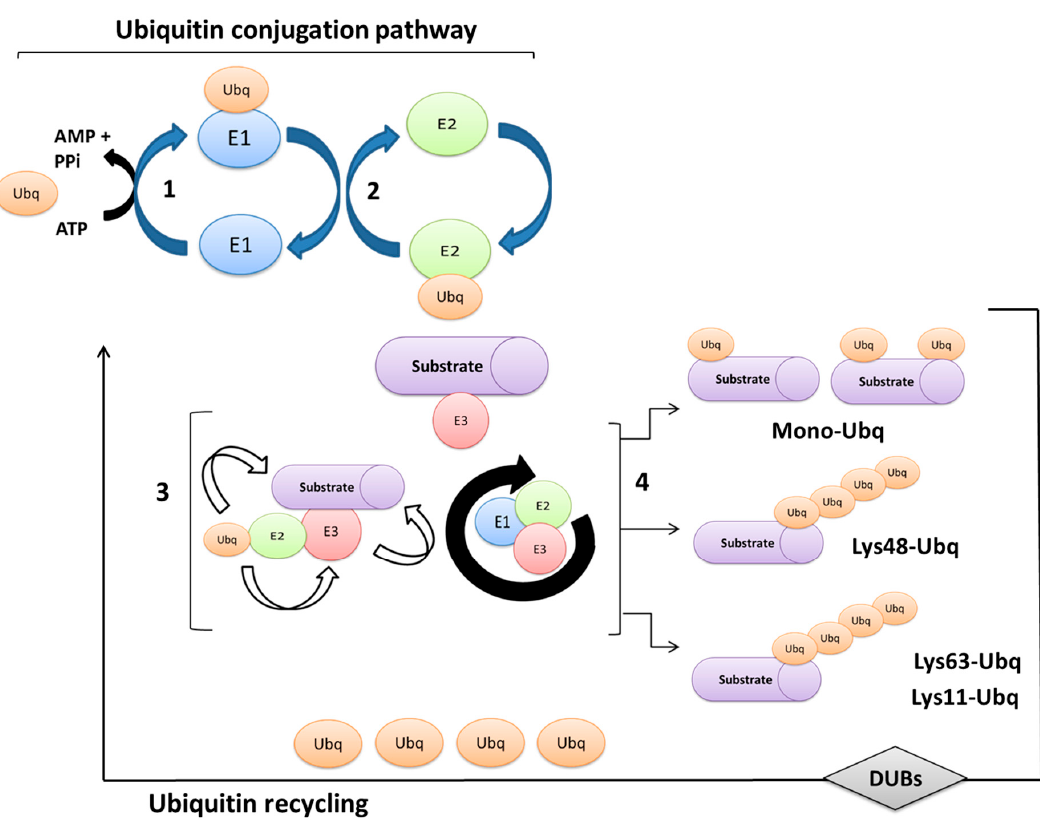
Figure 1. Schematic overview of the ubiquitin conjugation pathway. Ubiquitination is a three step process involving specific groups of enzymes, which are: ( 1 ) E1, ubiquitin (Ubq) activating enzyme; ( 2 ) E2, Ubq conjugating enzyme and ( 3 ) E3, Ubq ligase enzyme. Ubq is known to form covalent bonds with protein substrates ( 4 ) which, once modified, are subjected to different fates. De-ubiquitinating enzymes (DUBs) remove ubiquitins from substrate proteins.